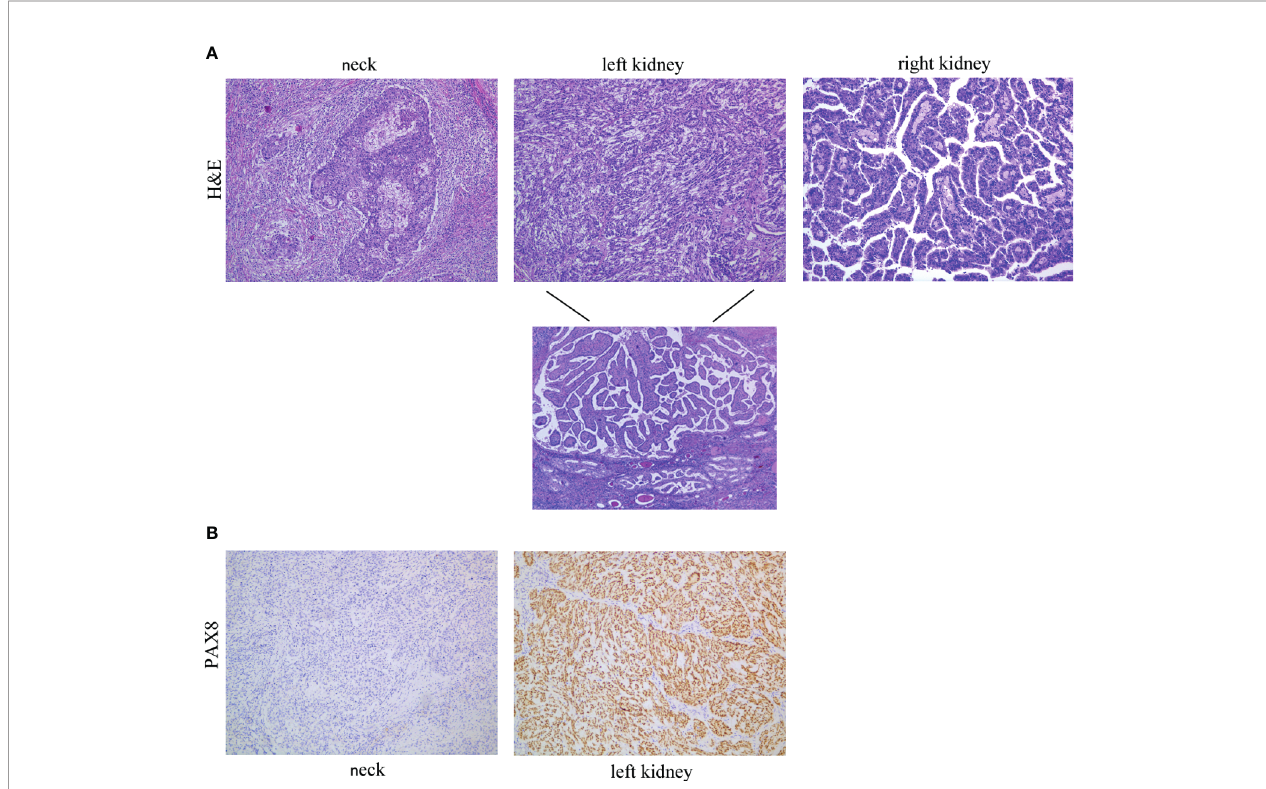
FIGURE 1 | (A) Pathological examination of cervical mass revealed squamous cell carcinoma (left panel); pathological fi ndings for the renal tumor were a mixed pattern of mucinous tubular and spindle cell carcinoma (MTSCC) with papillary adenoma in the left kidney (middle panel); and a papillary renal cell carcinoma (PRCC) in the right kidney (right panel). (B) Neoplastic cells in the neck and left kidney showed negative and positive staining for PAX8,